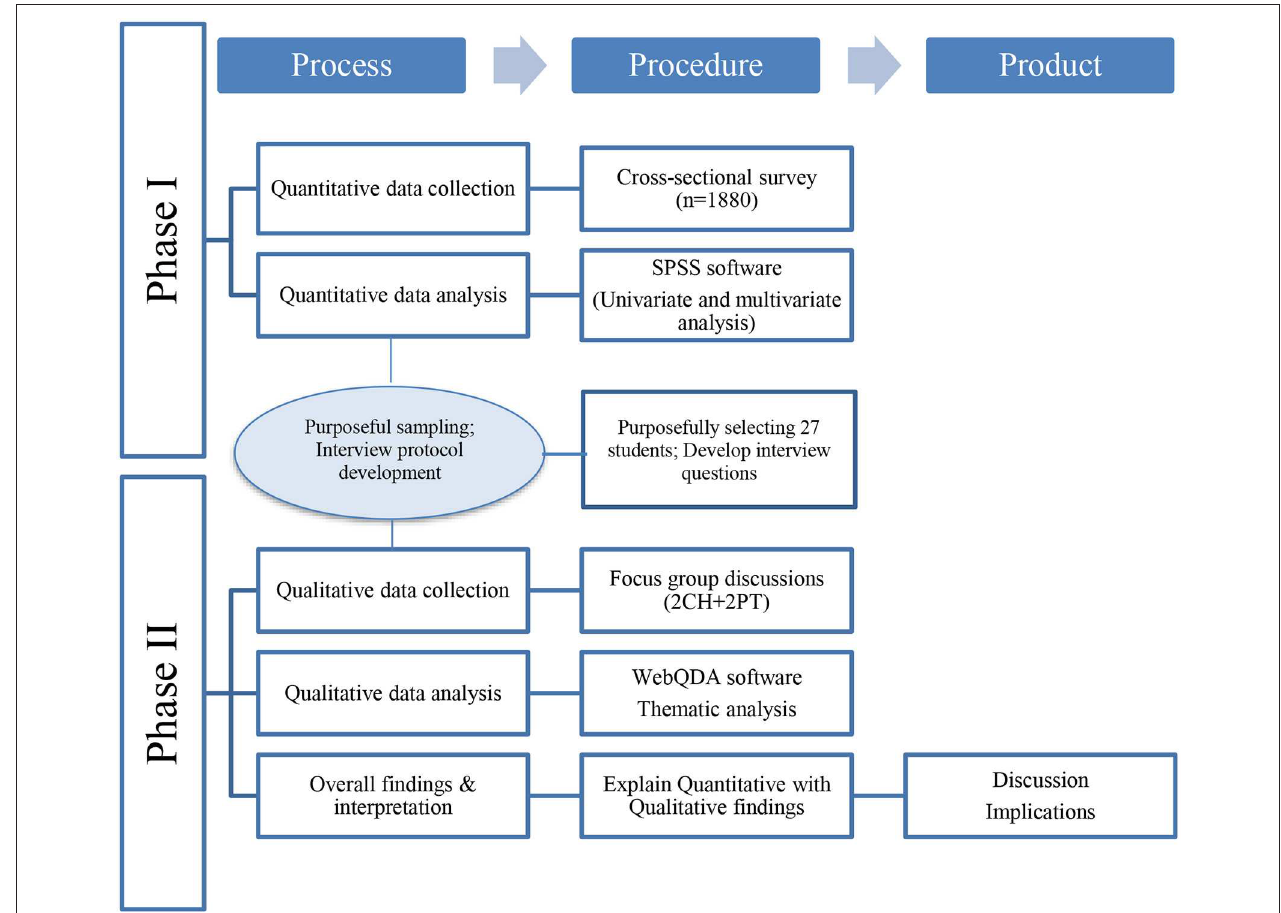
FIGURE 1 | Process flow diagram of the procedures for this sequential explanatory mixed-methods